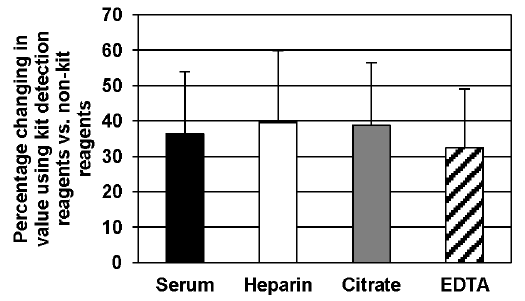
Figure 5. Comparison of SP-D values using two different detection antibodies. Serum, plasmas, and recombinant SP-D standard were detected using either kit reagents or non-kit reagents as described in the methods. SP-D concentrations in human samples were extrapolated from the standard curve as detected with the corresponding reagents. All values were significantly different (p , 0.05) by Wilcoxon signed rank test.